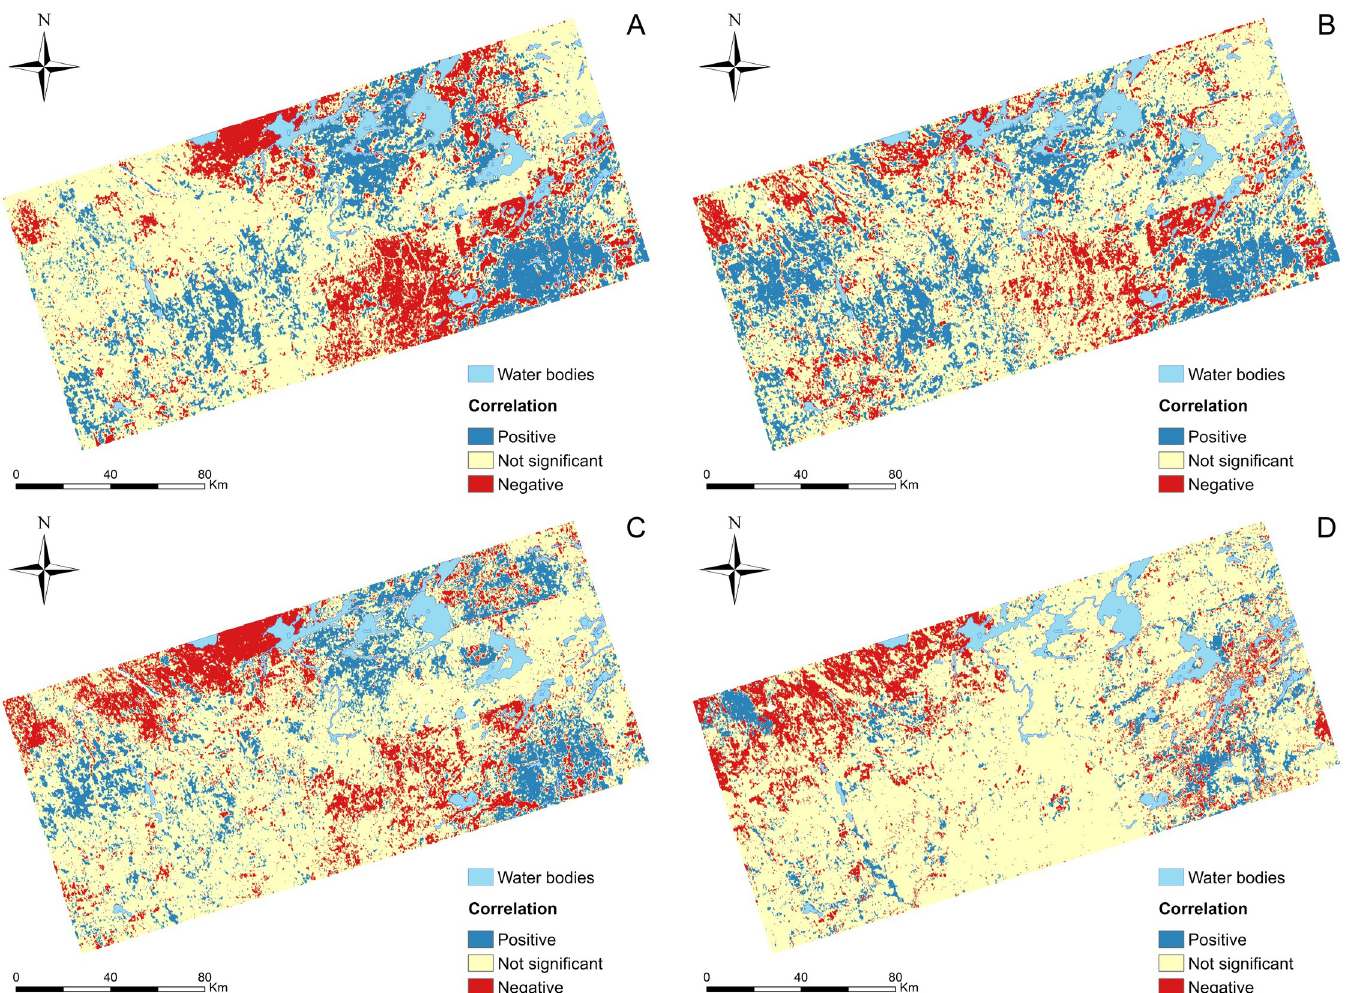
Fig 5. Correlation between rare and overall (A) bryophyte, (B) moss, (C) liverwort, and (D) sphagna species richness as measured by re-scaled Lee’s L statistic for the study area of [18] at 300 m spatial resolution. "Positive" (blue) and "Negative"(red) indicate significant positive (quantile > 0.975) and negative (quantile < 0.025) Lee’s L values derived from Monte Carlo test. Continuous values of the re-scaled Lee’s L statistic are shown in S1 Fig in S1 Appendix.